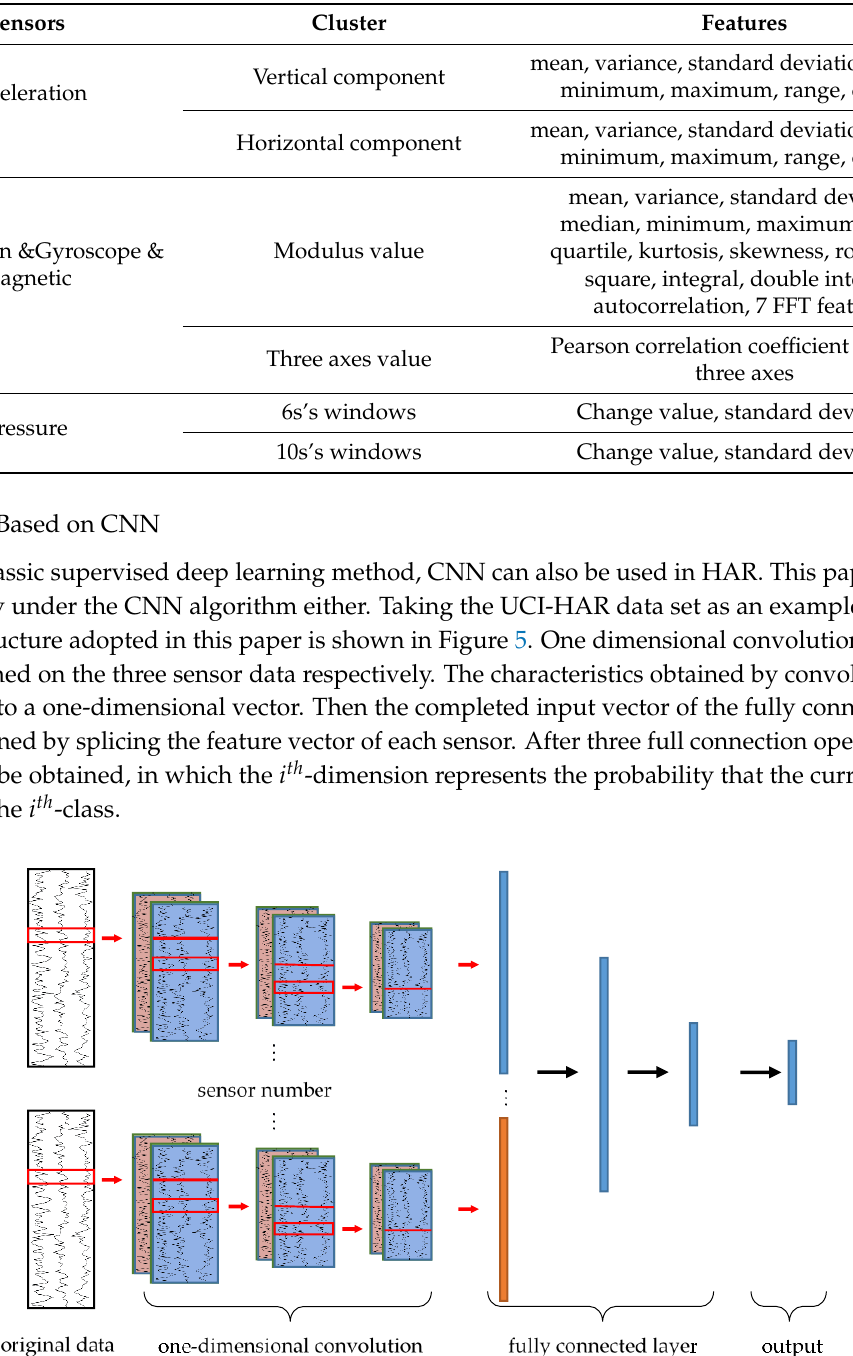
Table 5. The feature engineering of XGB algorithm.